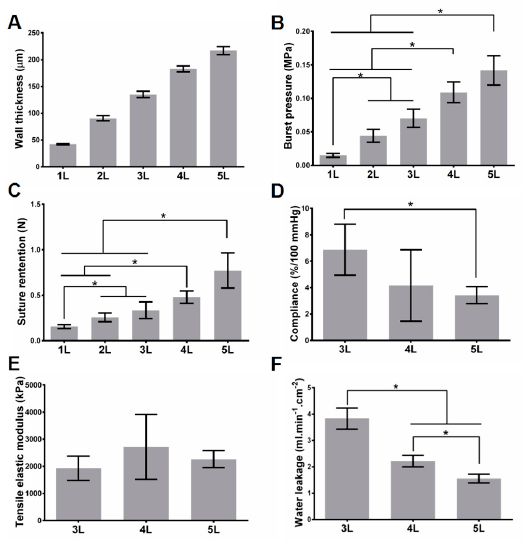
Figure 2. Mechanical properties for cell-free scaffolds. ( A )–( C ) Wall thickness ( A ), burst pressure ( B ), and suture retention ( C ) of scaffolds with 1–5 layers. ( D )–( F ) Compliance ( D ), tensile elastic modulus ( E ), and water leakage ( F ) of scaffolds with 3–5 layers. Data of ( D ), ( E ) and ( F ) do not have the results of 1 and 2 layered scaffolds, because the scaffolds with 1 and 2 layers cannot bear the pressure of 120 mmHg. All tests were biological triplicates. * indicates the p value smaller than 0.05.